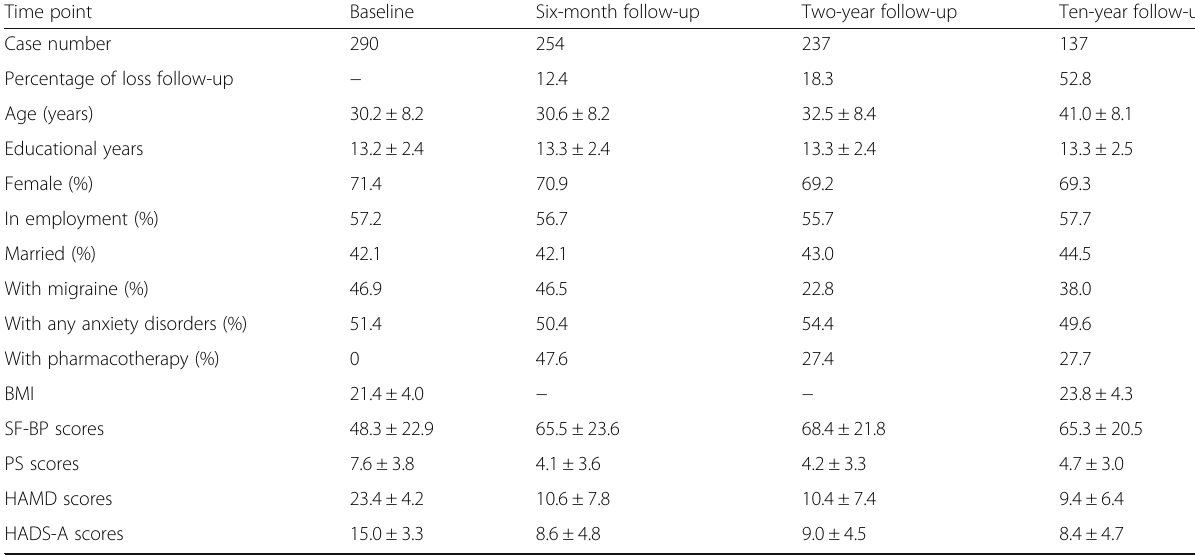
Table 1 Demographic variables, pain indices, and psychometric scores at different time points among patients with major depressive disorder Time point